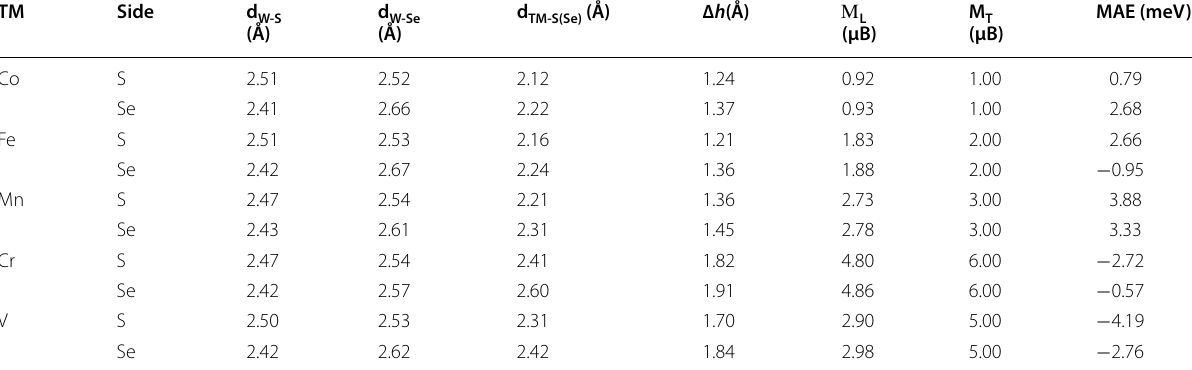
Table 2 The calculated results including the bond length (d moment M , the local magnetic moment M T